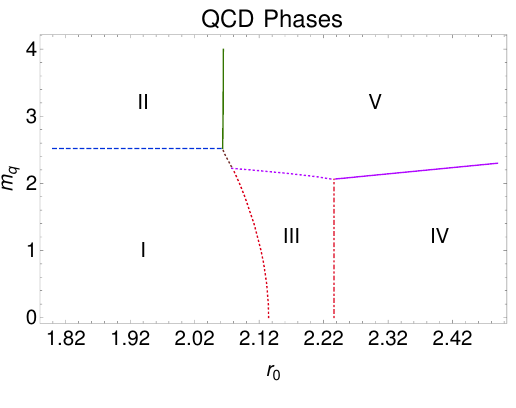
Figure 21 . Phase